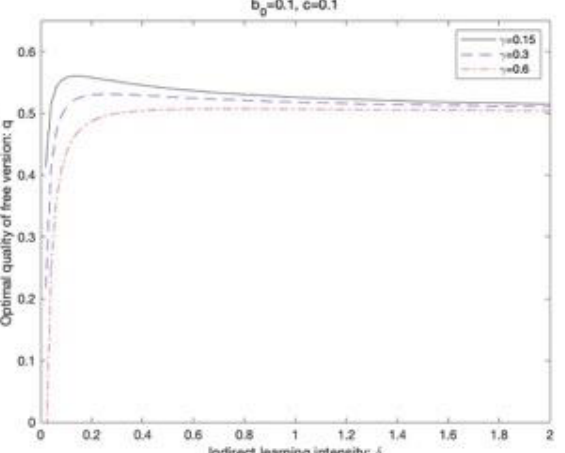
Figure 8. The impact of indirect learning intensity 𝛿 on the free trial strategy design.